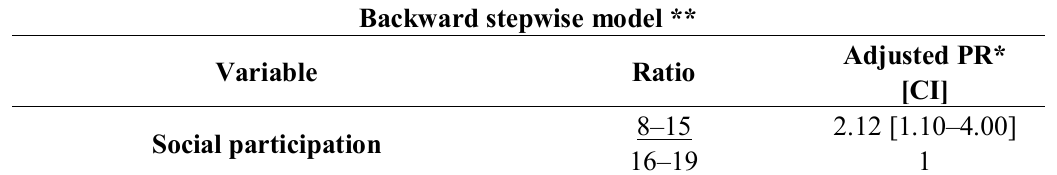
4. Poisson regression model explaining the presence of edentulism